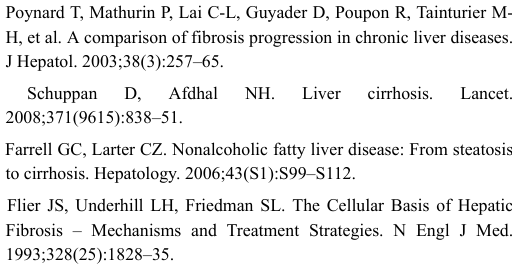
impression, calculation of the ld/crl-r recommended (ld: 1.6 cm, crl- r: 0.79, ld/crl-r: 20.2).